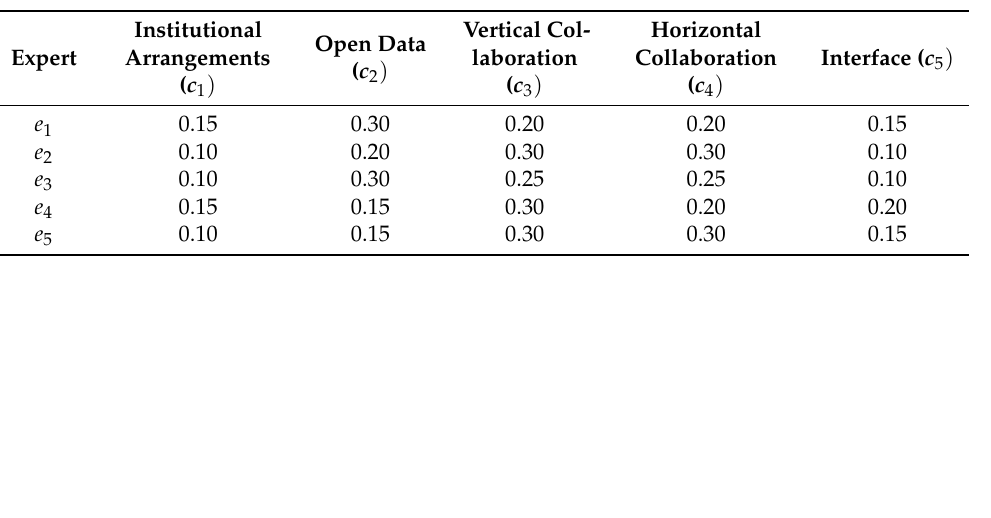
Table 1. Weights provided by the experts.